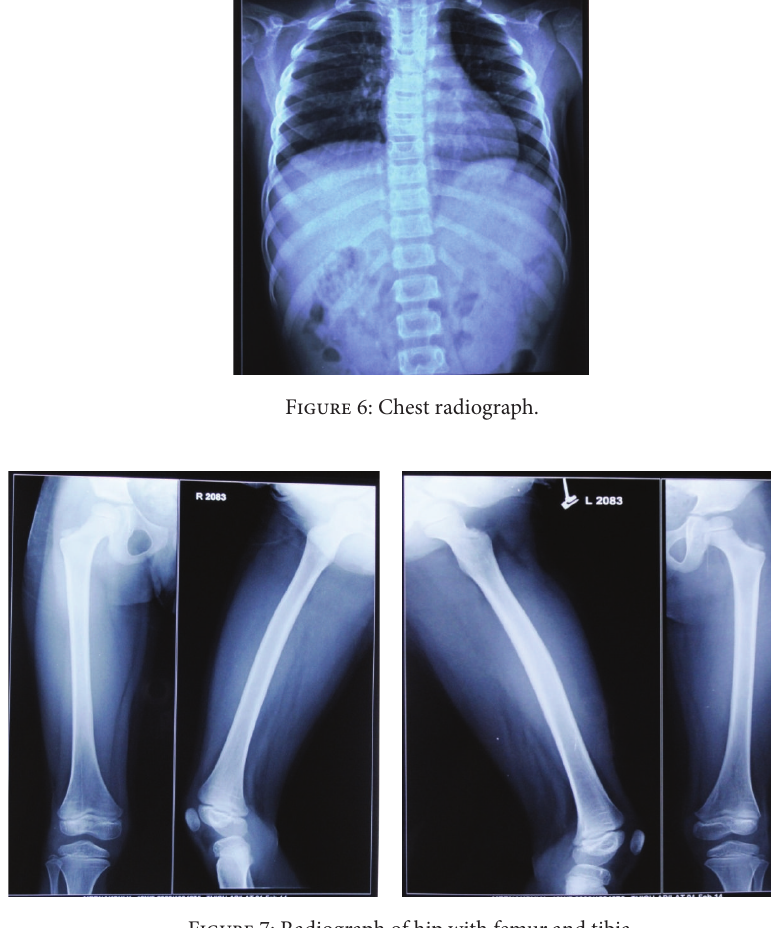
Figure 7: Radiograph of hip with femur and